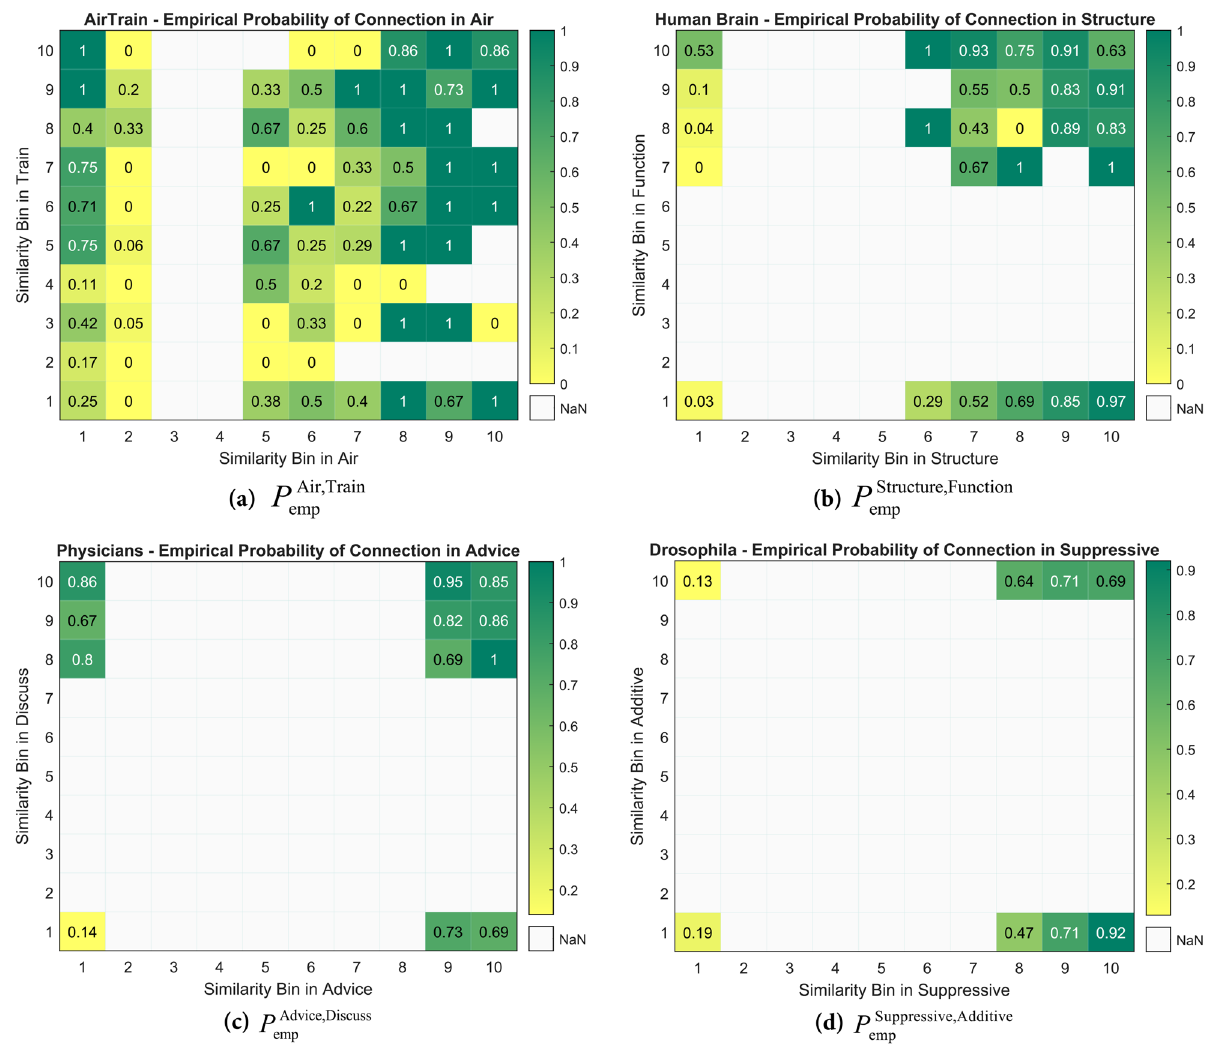
Figure 3. Empirical probability of connection in 2d-bins. The fraction of node pairs in the 2d-bins that are connected in the target layer( a ) ‘Train’ of the network Air/Train w.r.t ‘Air’, ( b ) ‘Function’ of Human Brain w.r.t ‘Structure’, ( c ) ‘Discuss’ of Physicians w.r.t ‘Advice’, ( d ) ‘Additive’ of Drosophila w.r.t ‘ Suppressive’ layer. NaN (Not a Number) values represent 2d-bins that contain no sample